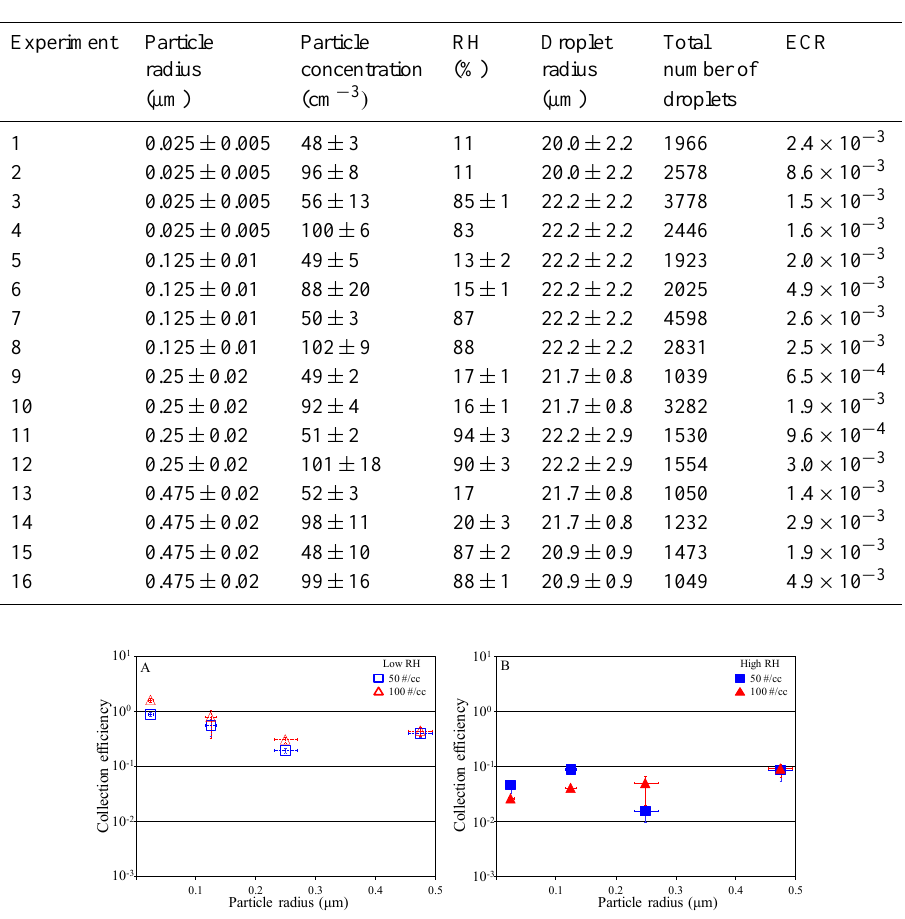
Figure 5. CE calculated as a function of particle radius. Shapes represent different aerosol concentrations. CE error bars are based on droplet size, aerosol size and aerosol number concentration measured from each experiment as described in Eq. (3). (a) Low-RH experiments. (b) High-RH